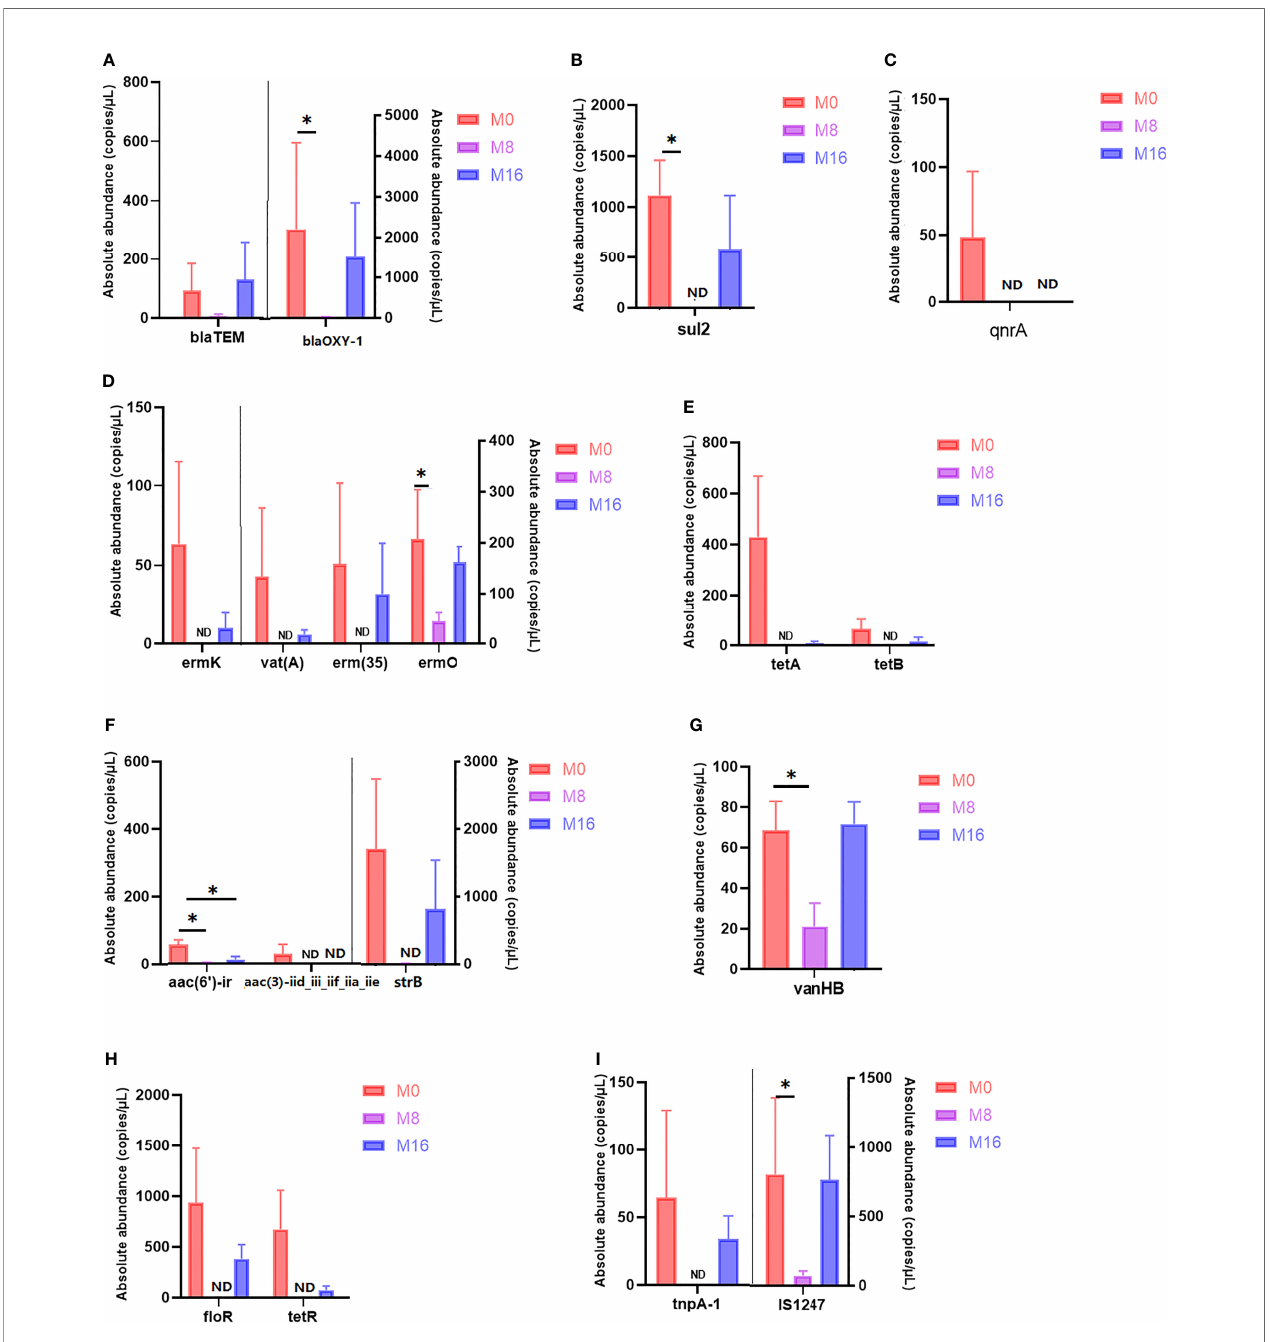
FIGURE 7 | Quantity of antibiotic resistance genes in M0, M8, and M16. *Signi fi cant difference between treatments ( p < 0.05). (A) Beta-lactam, (B) sulfonamide, (C) fl uoroquinolone, (D) macrolide – lincosamide – streptogramin (MLSB), (E) tetracycline, (F) aminoglycoside, (G) glycopeptide, (H) multidrug, and (I) transposase. (A – H) ARGs; (I) MGEs. ARGs, antibiotic resistance genes; MGEs, mobile genetic